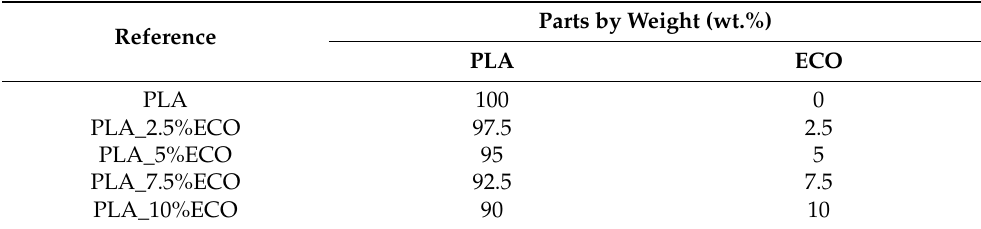
Table 1. Composition of ECO plasticized PLA materials and